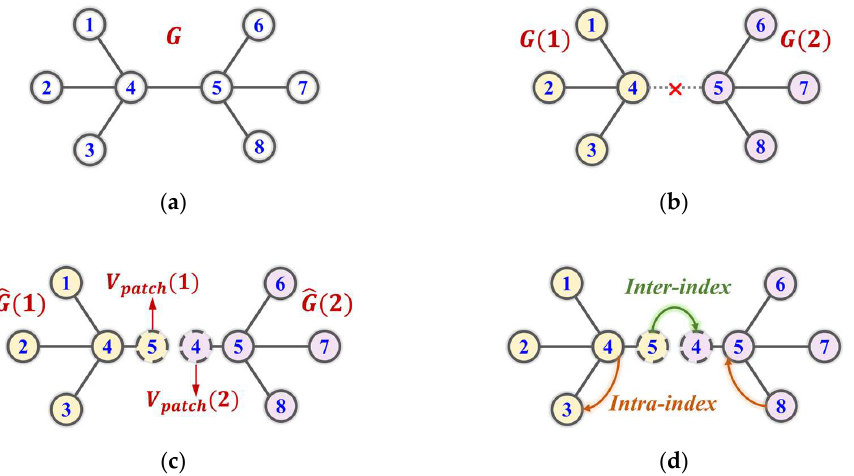
Figure 3. Illustration of the large-scale road network organization method. ( a ) Original road network; ( b ) optimal partition; ( c ) subgraph repair; ( d ) walk index calculation.